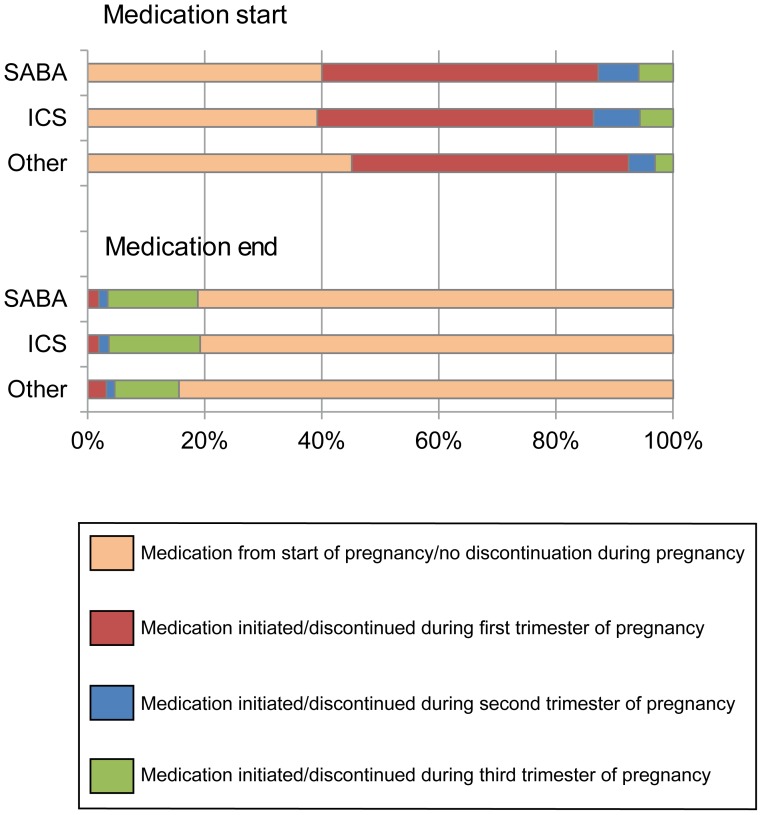
Asthma medication during trimesters.Starting and ending of treatment with asthma drugs (short-acting β2-agonists, SABA; inhaled corticosteroids, ICS and others (long-acting β2-agonists LABA and leukotriene receptor antagonist LTRA) in the Medical Birth Register.